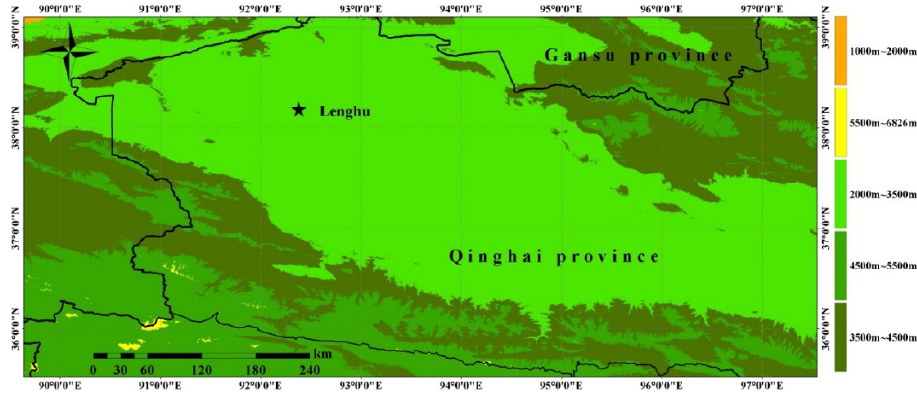
Fig. 5. Altitude (elevation from sea level).